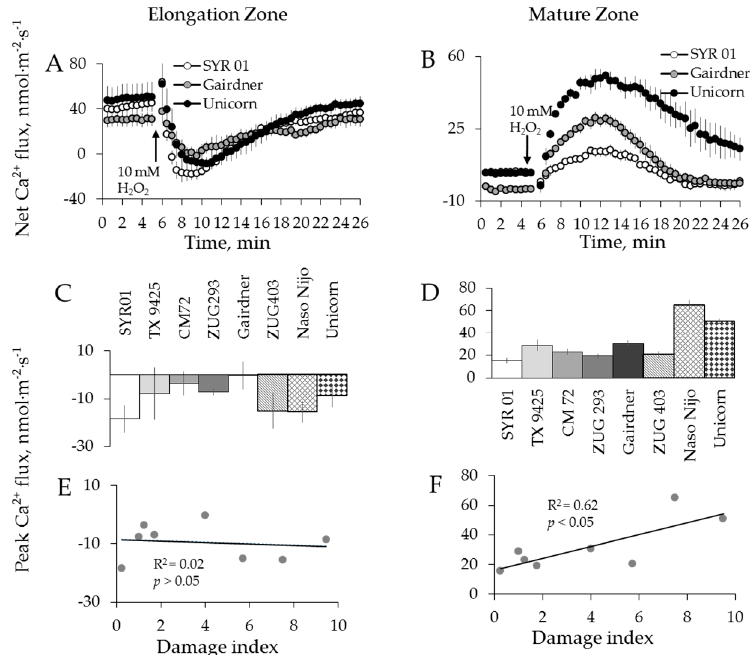
Figure 5. Kinetics of Ca 2+ fluxes from three representative barley varieties in response to 10 mM H 2 O 2 treatment from both root elongation zone ( A ) and mature zone ( B ). Error bars are means ± SE ( n = 6–8). ( C , E ) Peak Ca 2+ fluxes ( C ) of eight barley varieties in response to 10 mM H 2 O 2 and their correlation with damage index ( E ) in root elongation zone. ( D , F ) Peak Ca 2+ fluxes ( D ) of eight barley varieties in response to 10 mM H 2 O 2 and their correlation with damage index ( F ) in root mature zone.